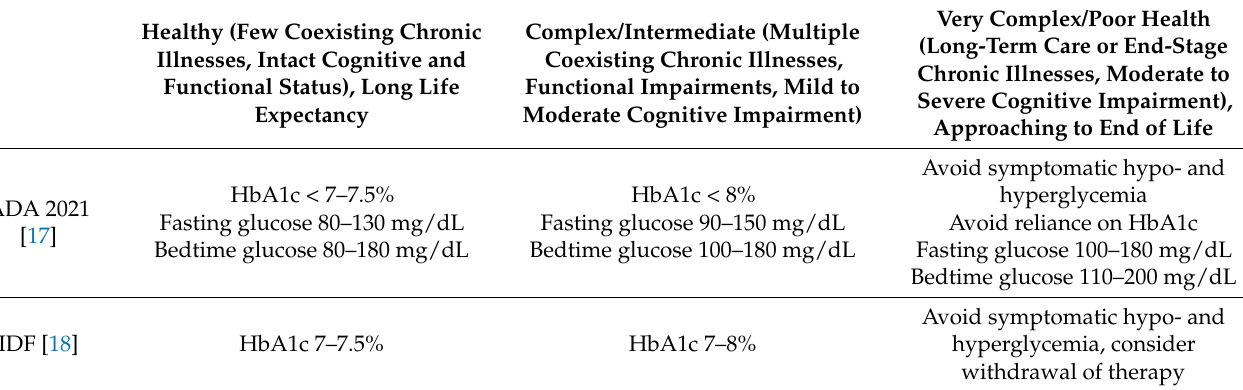
Table 1. Treatment goals for glycemia in older adults with